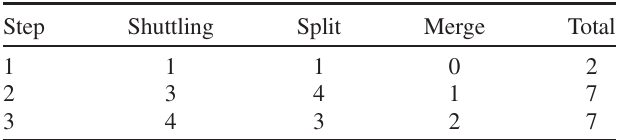
TABLE III. Required number of shuttling, split, and merge operations to realize each of the first three plaquettes of the TN diagram for the given trap configuration; see Fig.